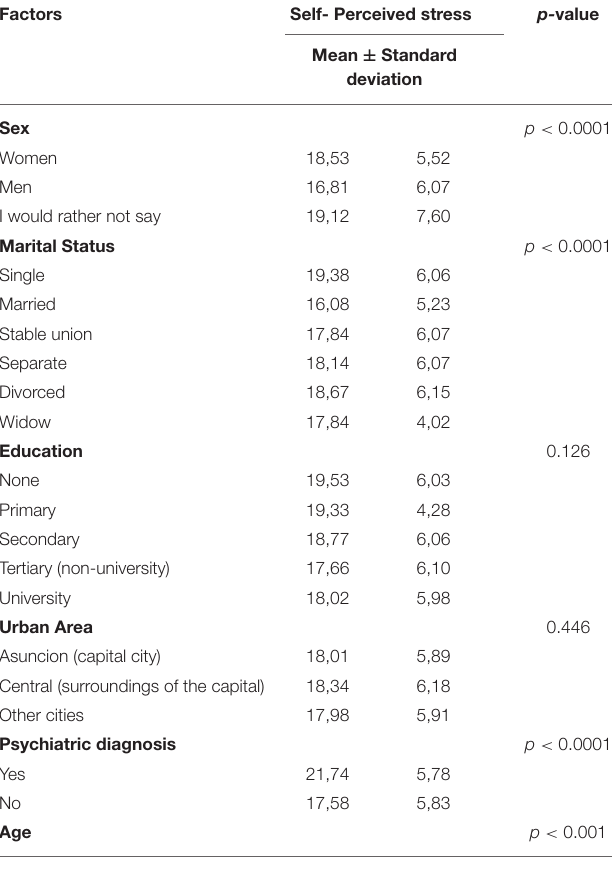
TABLE 4 | Factors associated to self-perceived stress in the sample ( N = 2,206). TABLE 5 | Mental health factors associated to Self-perceived stress in mentally ill subjects ( n =